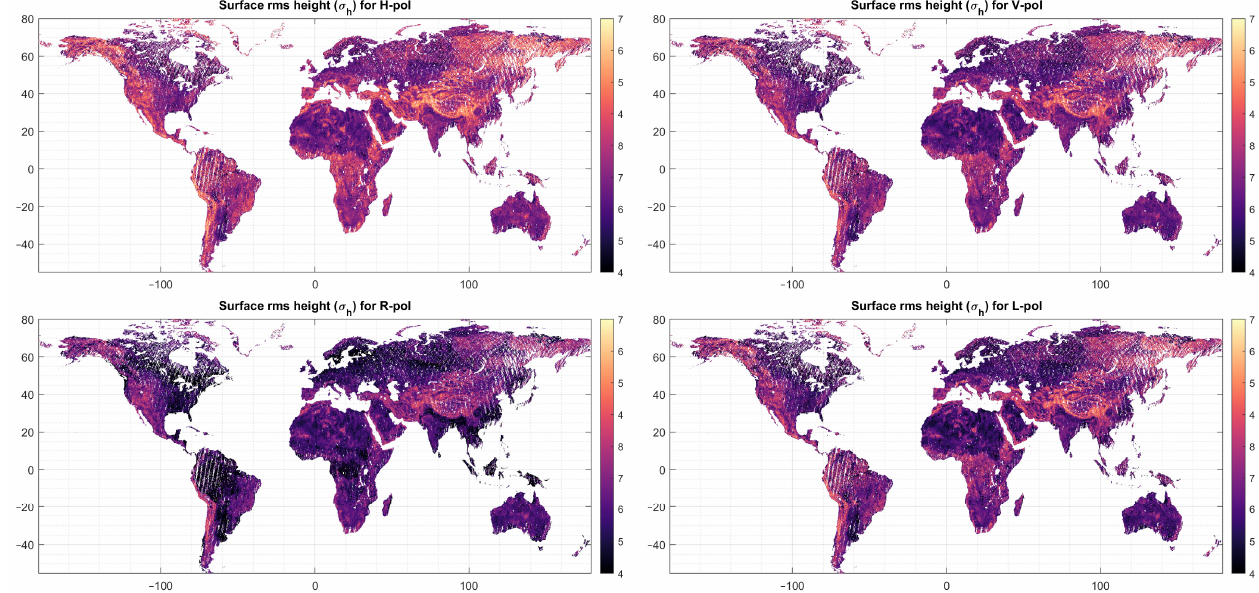
Figure 2. Surface rms height ( σ h ) for each polarization H, V, R, L, in centimeters [cm].